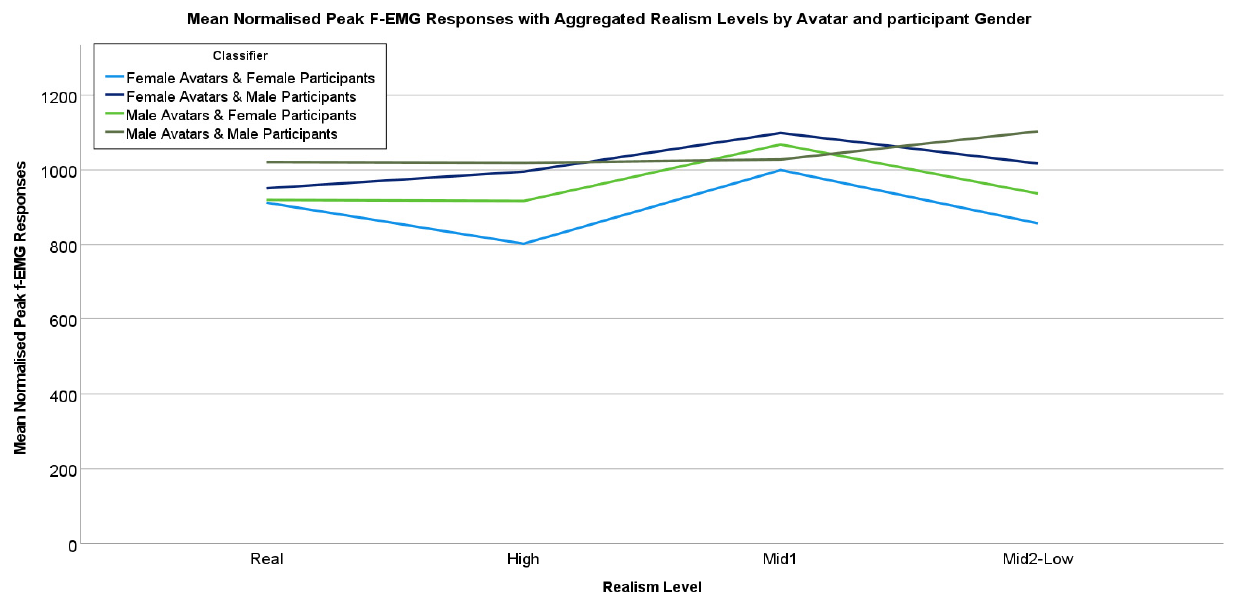
Figure 12. Mean normalized peak f-EMG responses for the realism levels by both avatar and partic- ipant gender(sex).